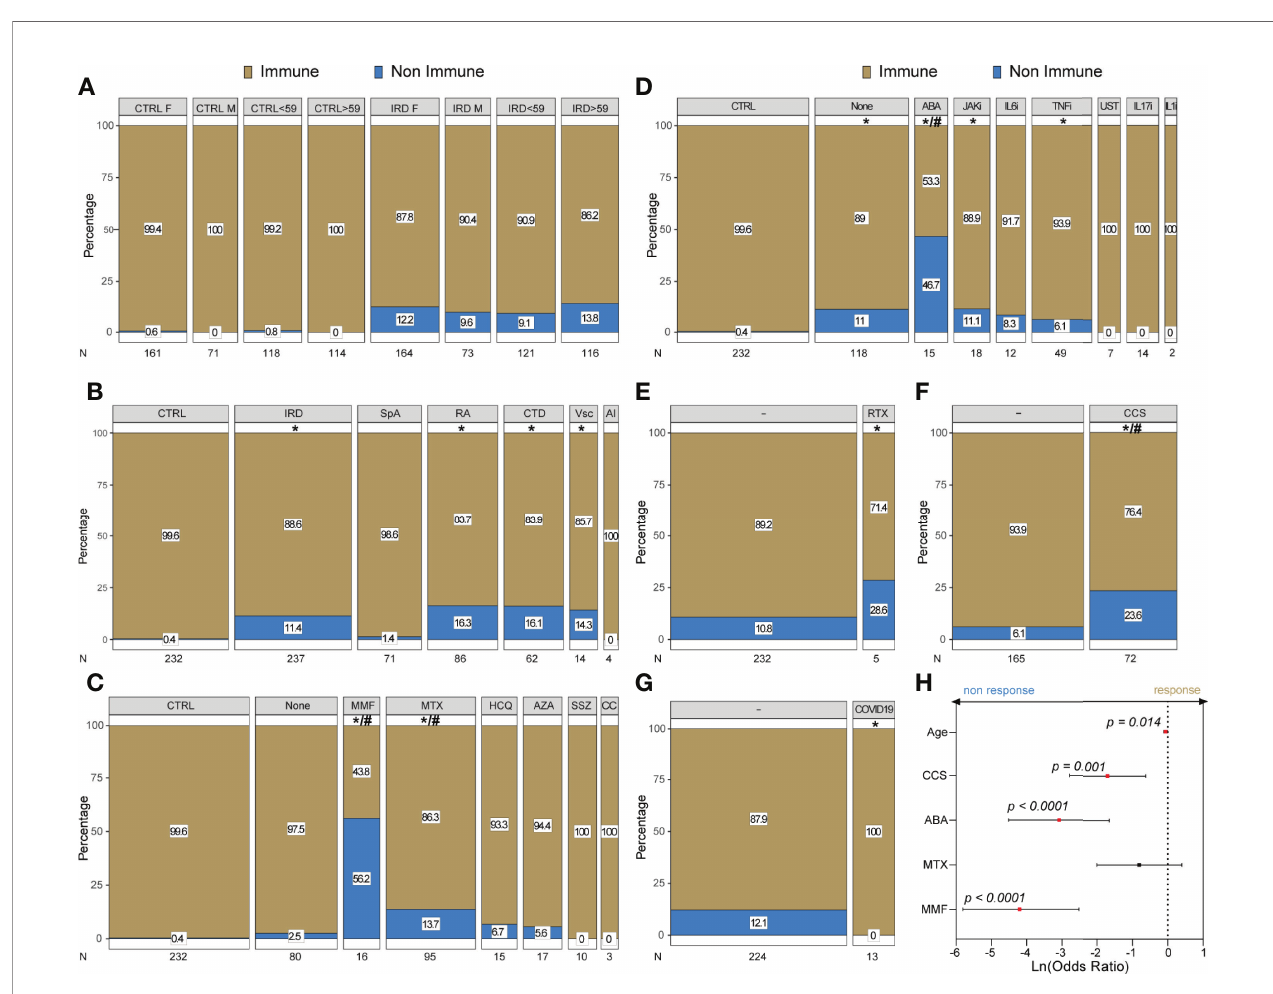
FIGURE 1 | Seroconversion rates after BNT162B2 vaccine in IRD and controls: Mosaic plots represent the percentage of serological response and non-response in controls (CTRL) and patients (IRD); bar size is proportional with the sample size (n) of the group. (A) strati fi cation according to sex and age (> vs < the median); (B) percentage of response across different IRD diagnoses; (C) response in patients treated with csDMARDs; (D) response in patients treated with bDMARDs or tsDMARDs; In (E – G) strati fi cation performed according to RTX treatment in the last 12 months, CCS use and past Sars-Cov-2 infection, respectively. In (H) forest plot showing factors associated with of seroconversion identi fi ed by binary stepwise logistic regression displayed as 95% CI of Ln(Odds Radio) and p-value. Full analysis results and p-values are reported in Supplementary Table 1 . *: statistically signi fi cant vs control population; #: statistically signi fi cant vs not taking csDMARDs or bDMARDs/tsDMARDs; */# = p <